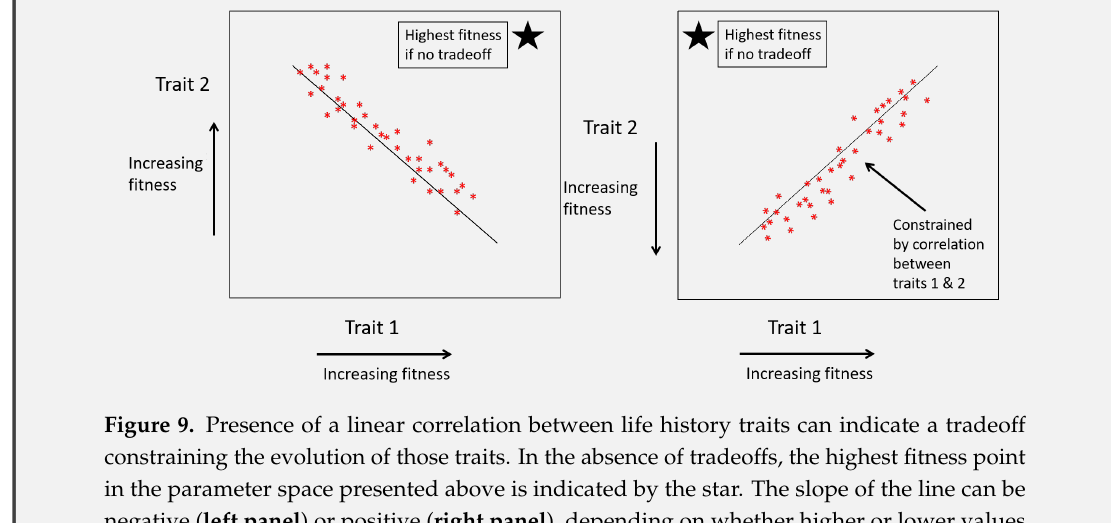
Figure 9. Presence of a linear correlation between life history traits can indicate a tradeoff constraining the evolution of those traits. In the absence of tradeoffs, the highest fitness point in the parameter space presented above is indicated by the star. The slope of the line can be negative ( left panel ) or positive ( right panel ), depending on whether higher or lower values of each trait are associated with higher fitness, but critically, it does not cross the area of highest fitness for both parameters